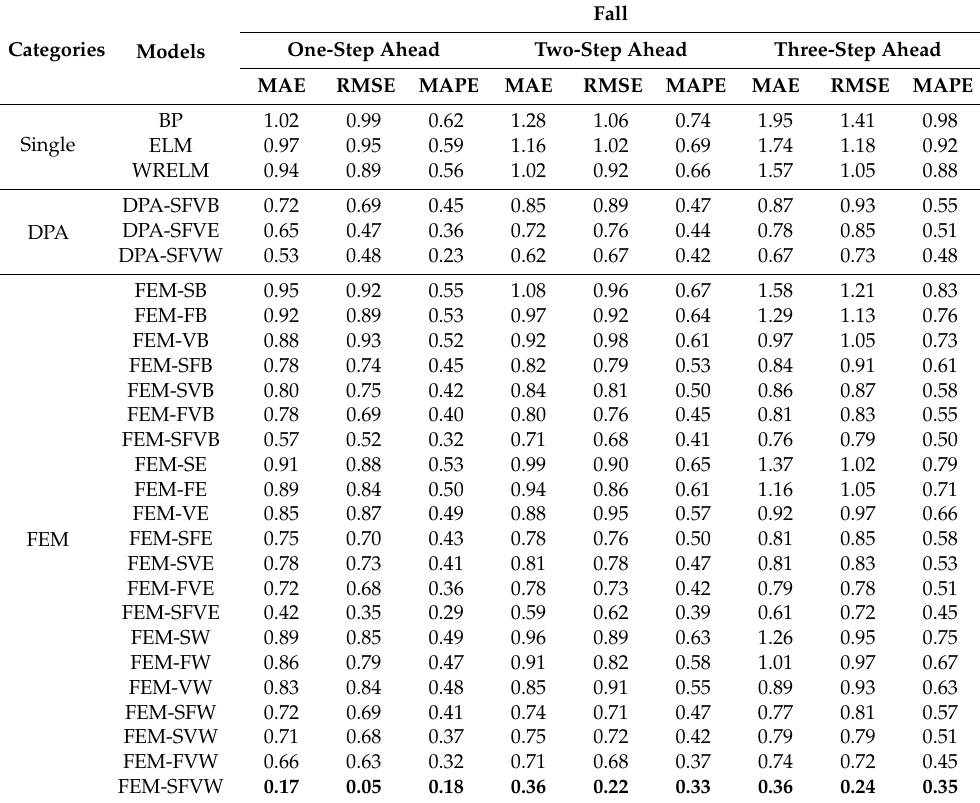
Table 8. Comparison of prediction performances of different models in fall.